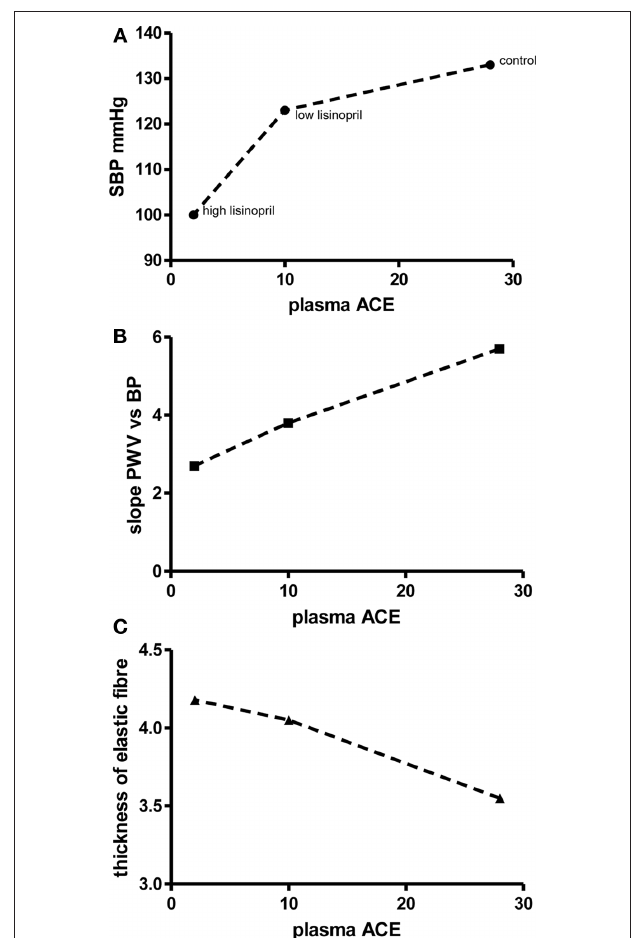
FIgure 4 | Increases in arterial distensibility produced by the ACeI, lisinopril (recalculated and redrawn from Makki et al., 1994). Four-month- old normotensive rats were treated orally for 9 months with a low dose of lisinopril (0.9 mg/kg/day) or a high dose (9 mg/kg/day). ACE was inhibited in a dose-related fashion but the low dose treatment did not significantly modify systolic blood pressure (A) . Arterial stiffness (judged from the relationship between pulse wave velocity and mean blood pressure) was reduced in a dose-dependent fashion (B) and this was probably due in part to a reduction in the loss of thickness of arterial elastic fibers with age (C)